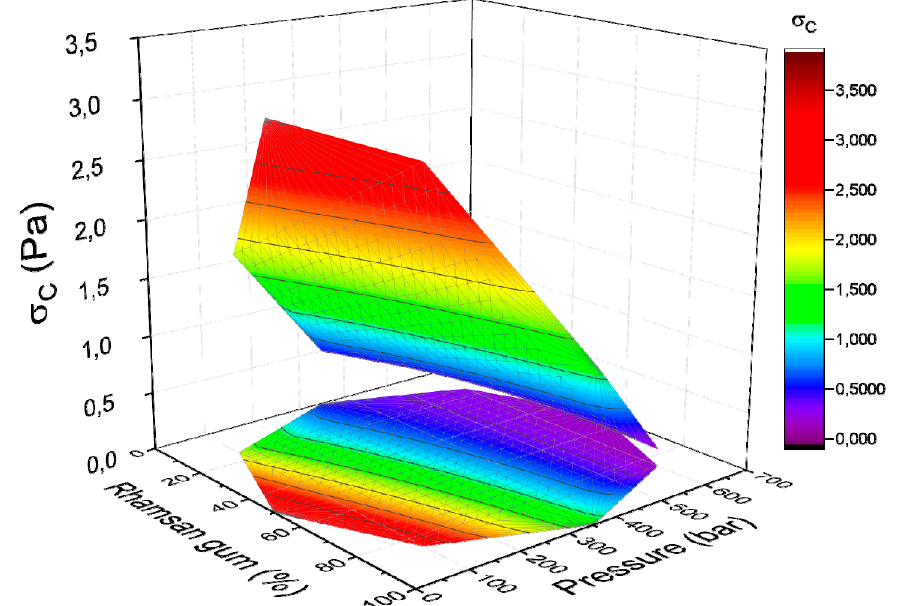
Figure 4. Three-dimensional response surface curve of critical shear stress ( σ c ) for rhamsan gum (%) and homogenization pressure applied in a microfluidizer.